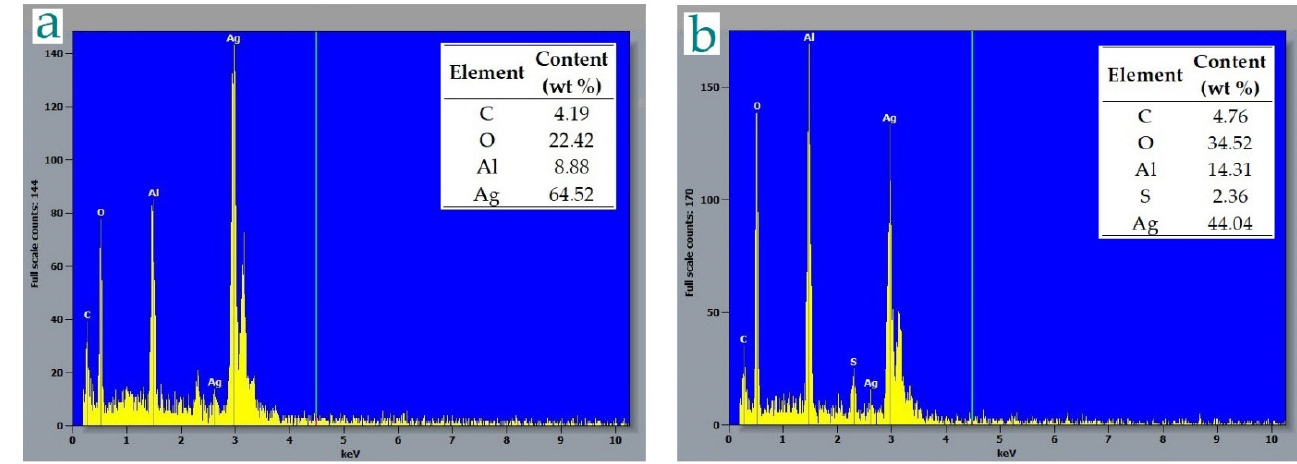
Figure 7. EDX spectra of ( a ) AE-8 and ( b ) BE-8.